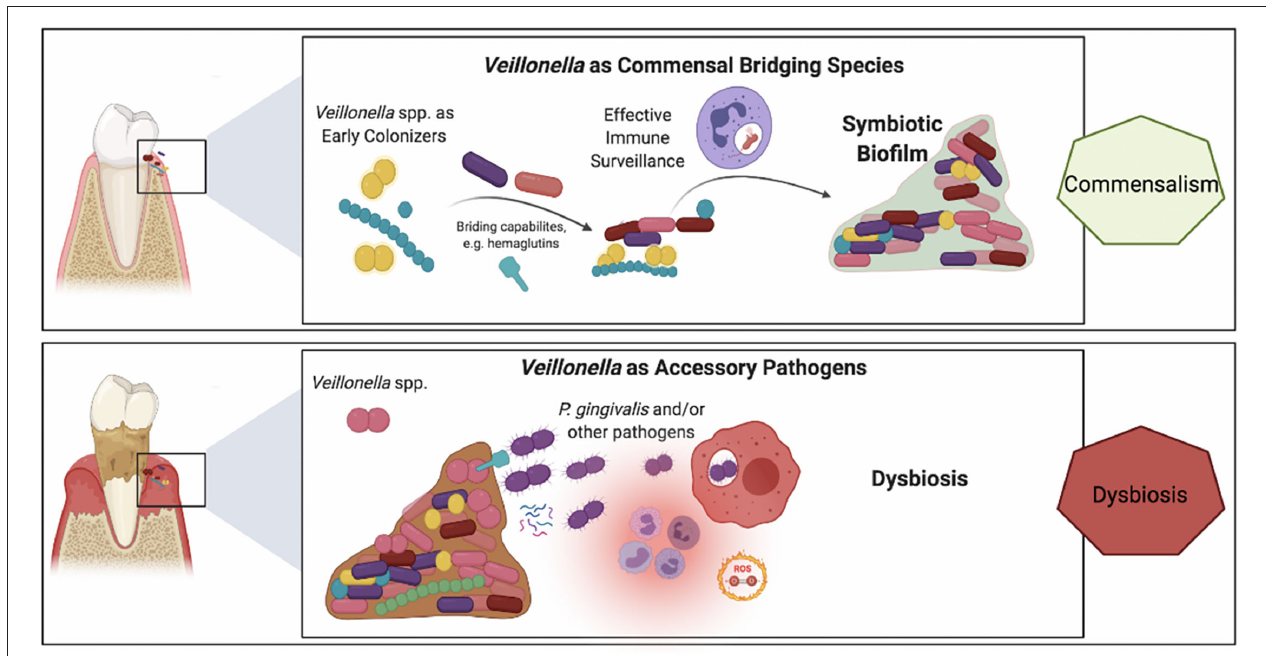
FIGURE 2 | Schematic representation of the purported roles of Veillonella spp. in a commensal biofilm associated with health vs. a dysbiotic microbial community associated with periodontitis. Veillonella spp. are highly abundant within oral biofilms and besides their well-established bridging role in commensal biofilms (top panel), their alternative ecological role of as accessory pathogens has recently emerged (lower panel). Upper panel: Veillonella spp. have a key role in the colonization of mineralized (e.g., tooth enamel or cementum) and metal (e.g., dental implants) surfaces within the oral environment. Demonstrating symbiotic mutualism with commensal streptococci, they are early and abundant colonizers that also provide immune stimulation by their mildly potent LPS, which may be beneficial to the host for heightened immune surveillance that contributes to the establishment of a dynamic healthy equilibrium. Lower panel: In the inflammatory environment of the crevice in the presence of biofilms with high plaque biomass the microenvironmental conditions vary within the biofilm. Differences in lactate concentrations, the prime carbon source for Veillonella , and differences in oxygen availability may trigger virulent mechanisms in certain Veillonella strains, such as hemagglutinin-1 that provide adhesion positions for P. gingivalis or small molecules that support P. gingivalis early growth and